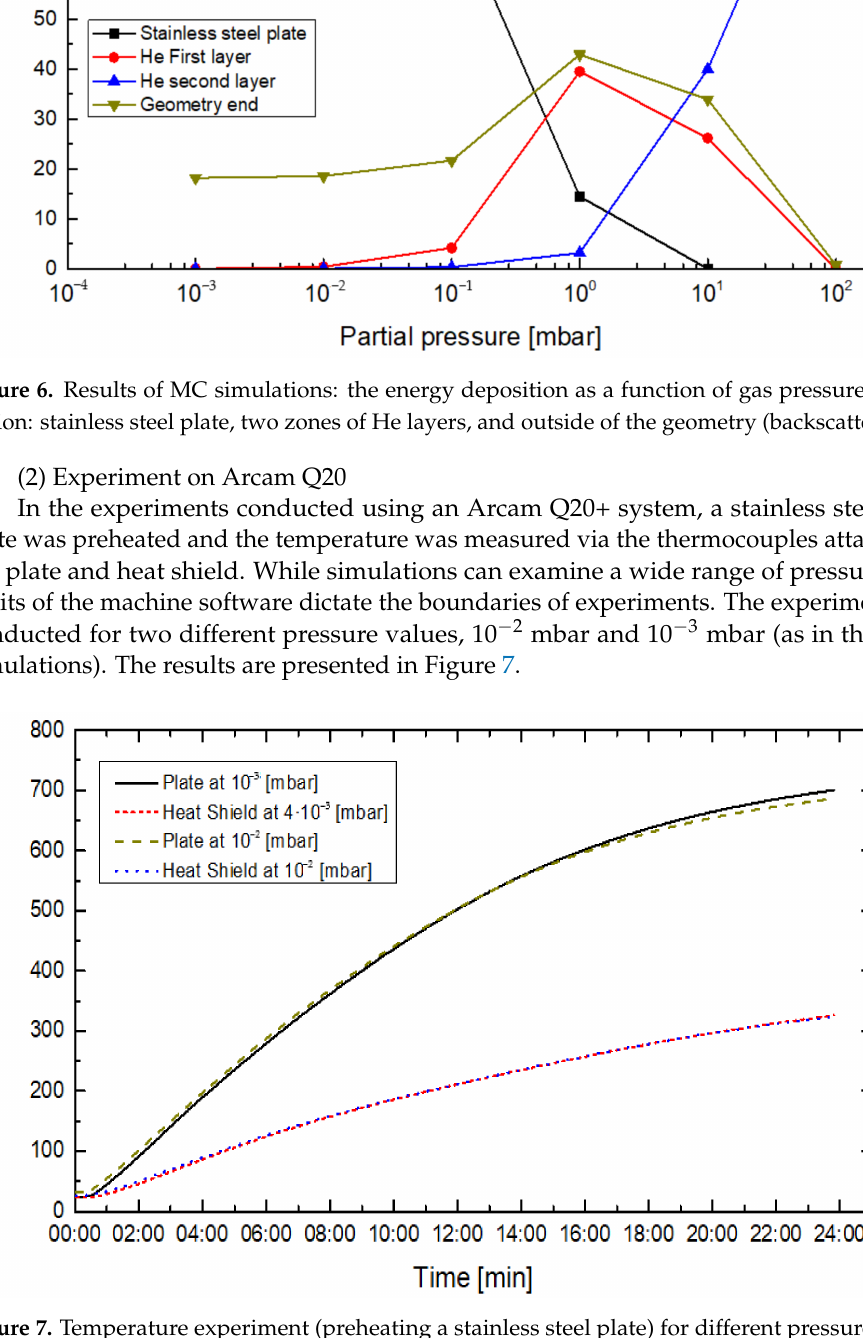
Figure 7. Temperature experiment (preheating a stainless steel plate) for different pressure values (10 − 2 mbar and 4 × 10 − 3